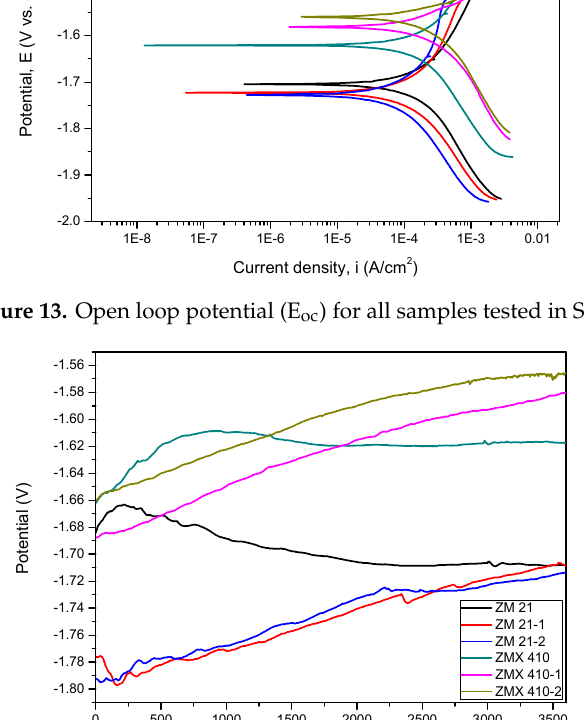
Figure 14. The Tafel curves of all samples tested in SBF. Table 3. Main parameters determined during the corrosion process performed in SBF.